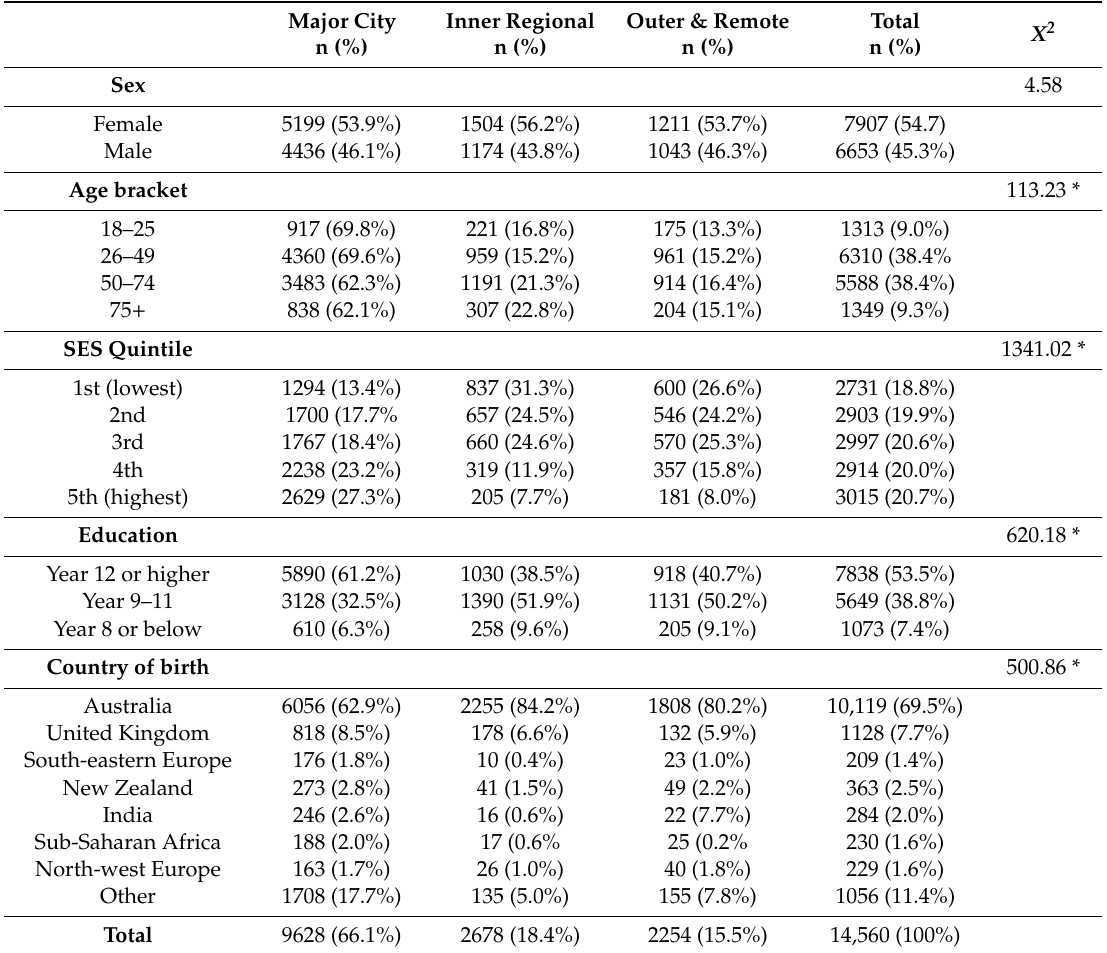
Table 1. Demographic characteristics according to remoteness